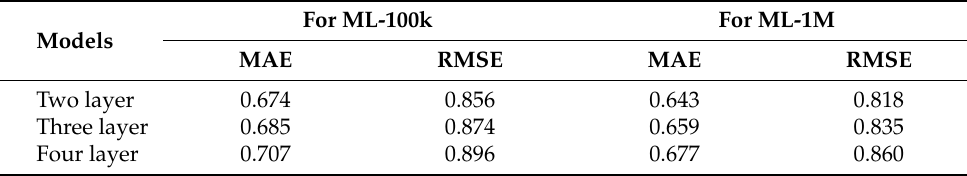
Table 6. Models performance result with different number of layers using both datasets.